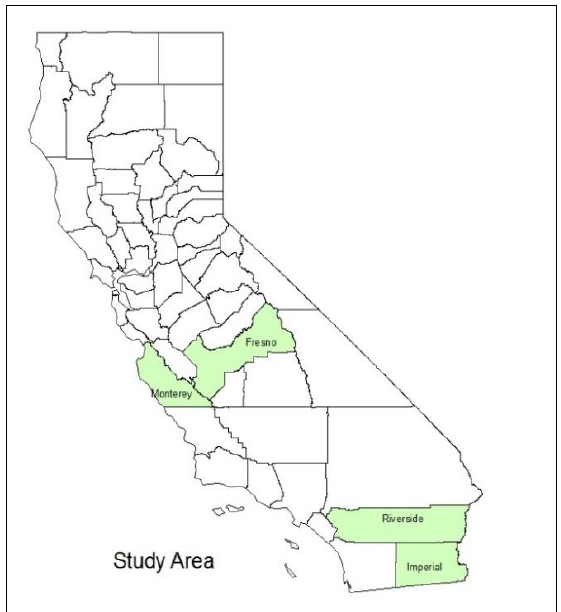
Figure 1. Map of the Study